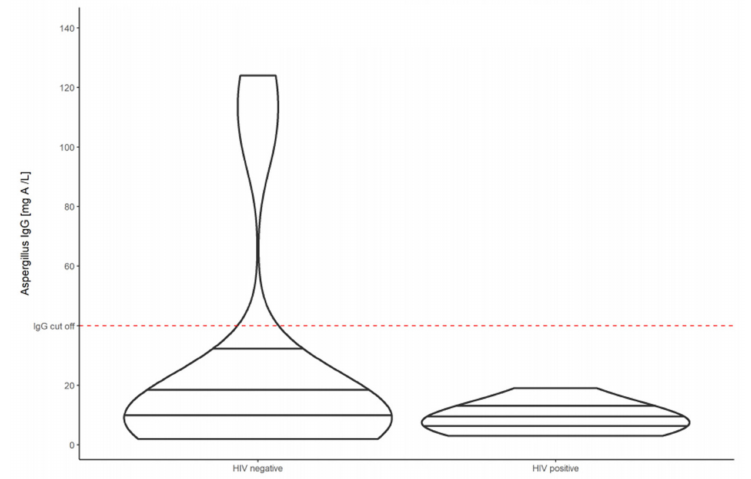
Figure 2. Violin plots showing the Aspergillus -specific IgG antibody levels of HIV-negative compared to HIV-positive patients with pulmonary tuberculosis at baseline. Table 1. Baseline